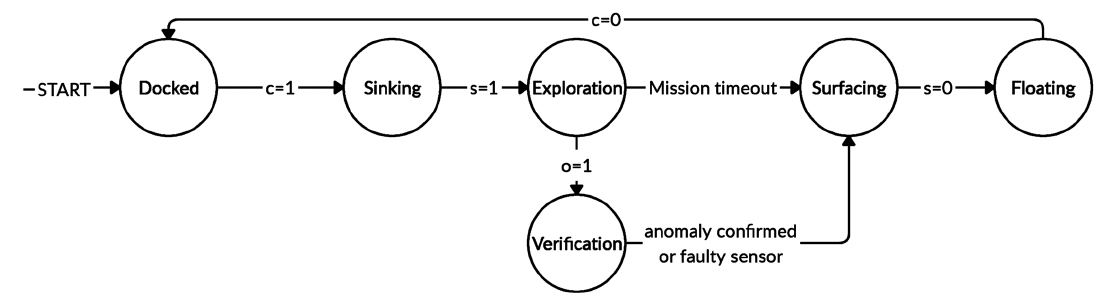
Figure 5. State machine of an aMussel in the exploration